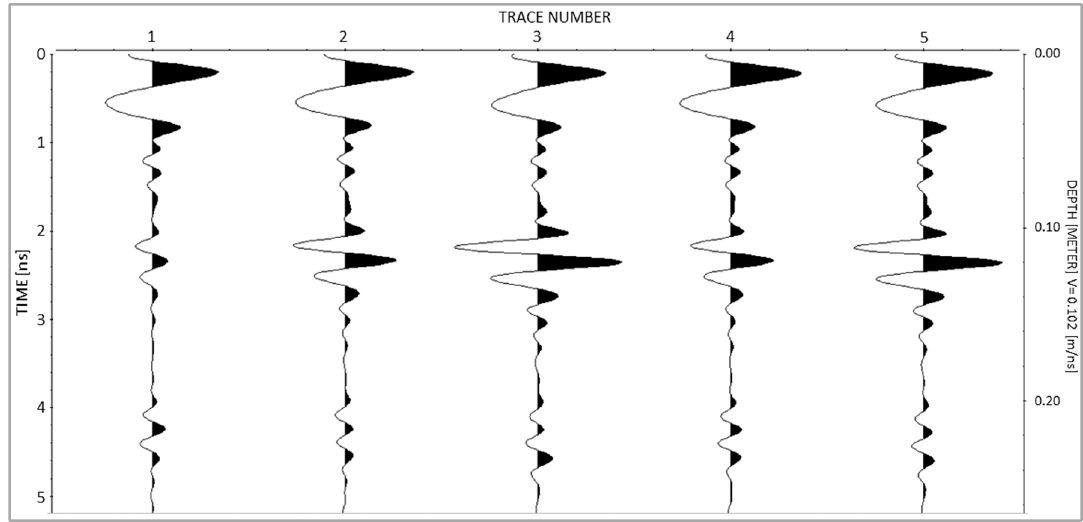
Figure 5. Data processing results for measurements on thin bed air-filled and resin-filled fractures. Note that the horizontal axis is the stacked trace number. The fracture thickness values and the filling material for these traces are: 1: 0 mm air, 2: 1 mm air, 3: 2 mm air, 4: 1 mm resin, 5: 2 mm resin.